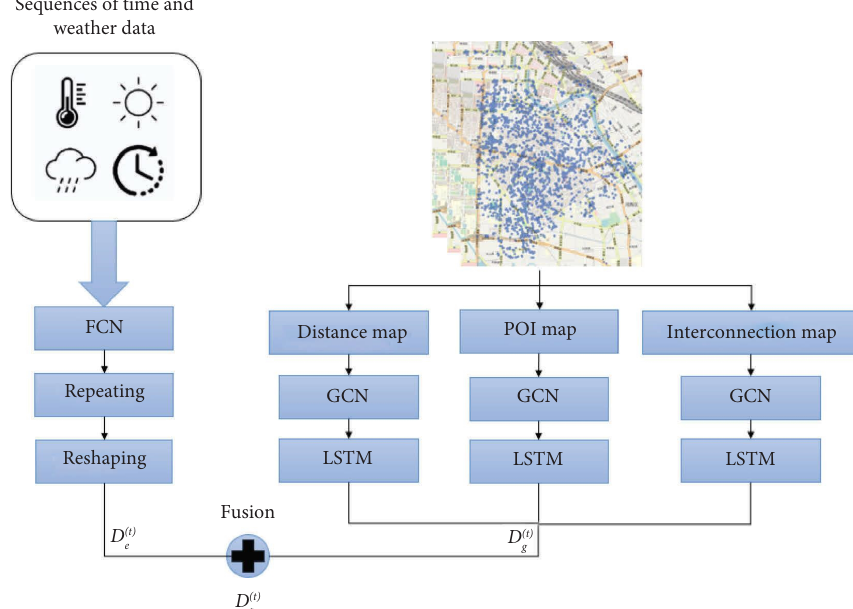
Figure 1: Te structural framework of